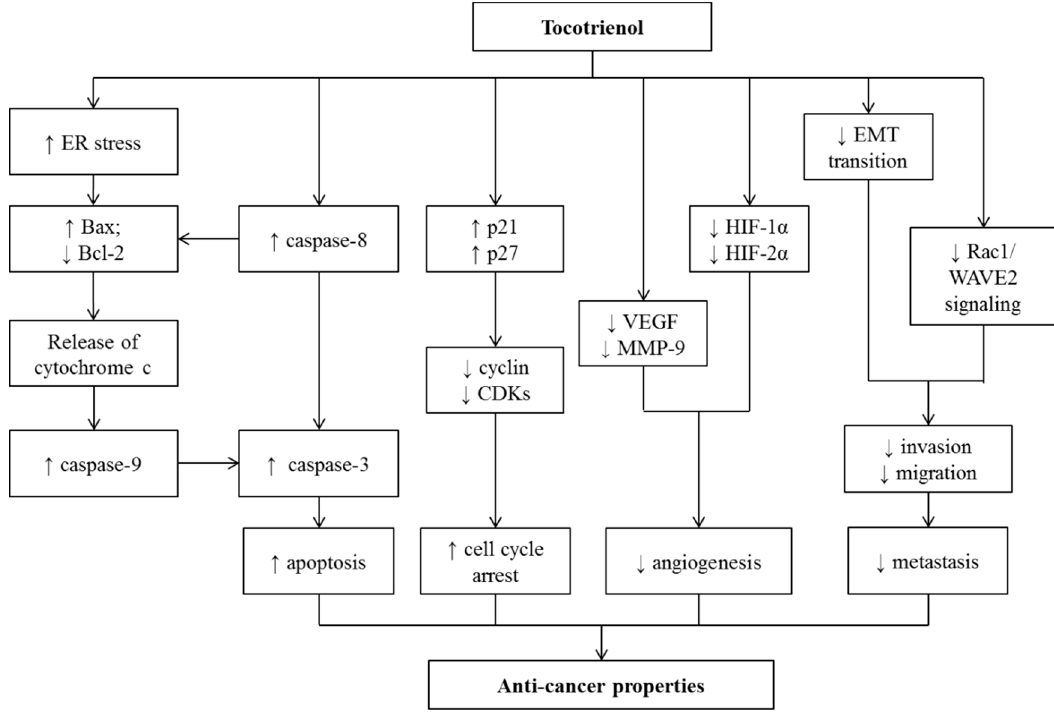
Figure 11. Anti-cancer mechanism of T3.